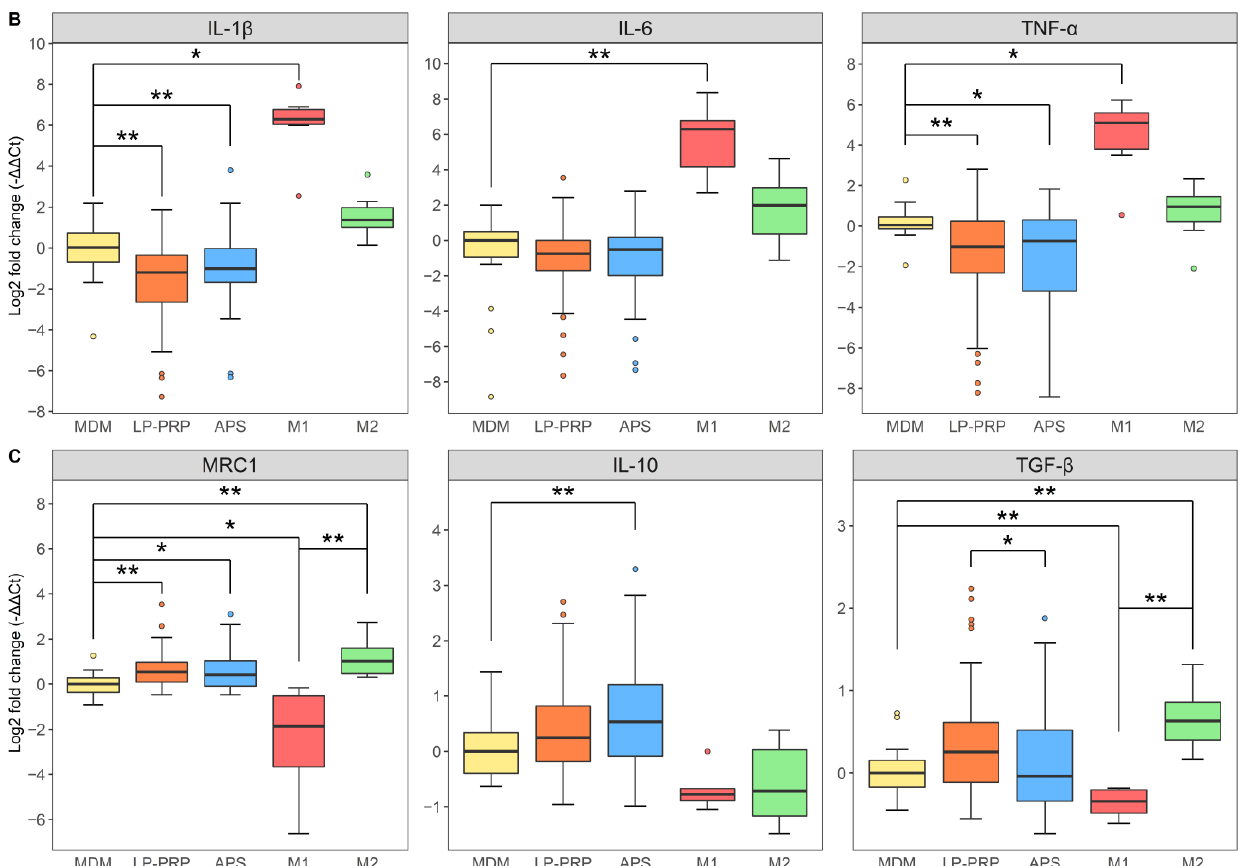
Figure 3. Effect of PRP supernatants on gene expression of M1/M2 macrophage markers. ( A ) Summary of this experiment. CD14 + monocytes were isolated from peripheral blood using density gradient centrifugation and magnetic beads. Monocytes were cultured in basal medium supplemented with 10% FBS containing M-CSF at 37 °C under 5% CO 2 for six days, then the medium was replaced by fresh basal medium supplemented with 10% FBS containing supernatants obtained from LP-PRP or APS, and the cells were cultured for another two days. ( B ) Gene expression of M1 macrophage markers (IL-1β, IL-6, TNF-α) and ( C ) M2 macrophage markers (MRC1, IL-10, TGF-β). Data were analyzed through qRT-PCR. -ΔΔCt values were calculated using GAPDH as an internal control. Monocyte-derived macrophages (MDM) control group served as negative control, and M1 and M2 polarized groups served as positive controls. MDM control group: 6 monocyte donors, 5 experiments, total n = 30; LP-PRP- and APS-added groups: 6 monocyte donors, 12 PRP donors, n = 72 group; M1 and M2 polarized groups: 6 monocyte donors, 2 or 3 experiments, n = 14 per group. * p < 0.05, ** p < 0.01.